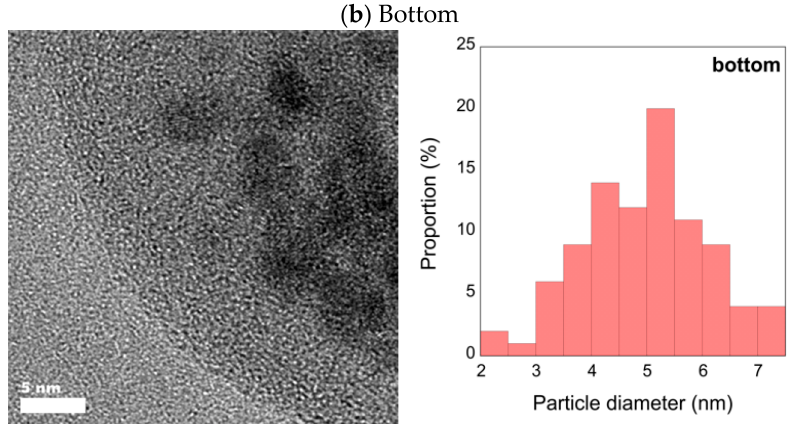
Figure 5. HR-TEM images of upper ( a ) and bottom ( b ) 1:1 Pd-Fe sample with particle diameter distribution.